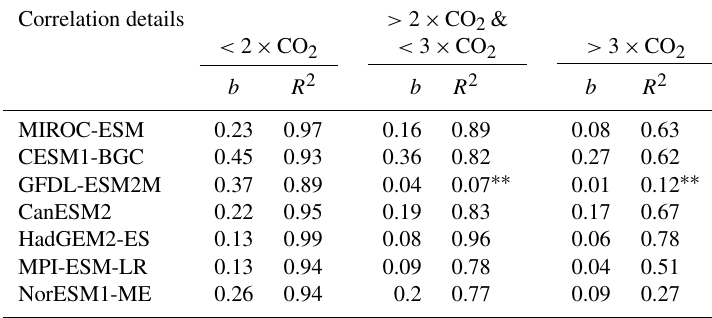
Table 2. Slopes ( b ) and coefficients of determination ( R 2 ) for regression between changes in LAI max against changes in annual mean GPP for the NHLs at different atmospheric CO 2 levels in all available CMIP5 models (1pctCO2 simulation). Asterisks denote nonsignificant values: ∗∗ p > 0 . 1; ∗ p > 0 .